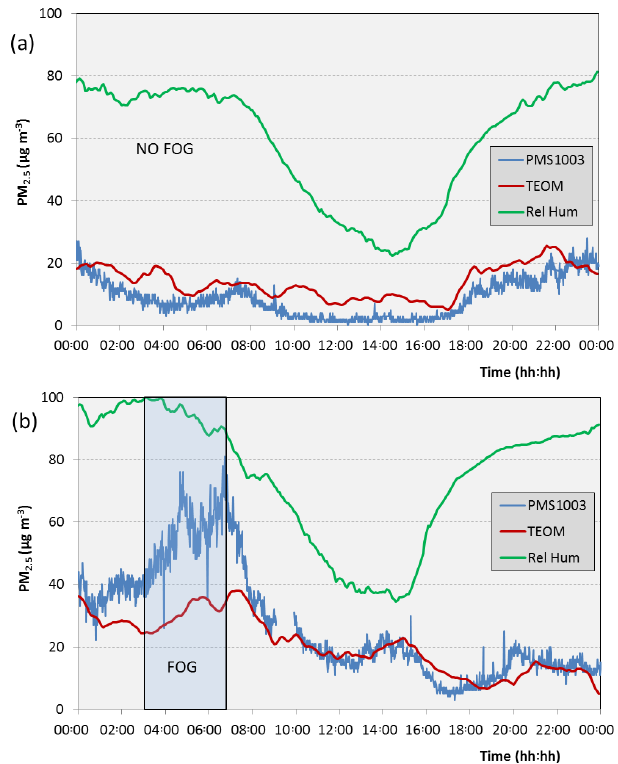
Figure 6. Variation of the PM 2 . 5 concentration reported by the PMS1003 and TEOM during a day (a) with no fog (24 July) and (b) with early morning fog (30 July).